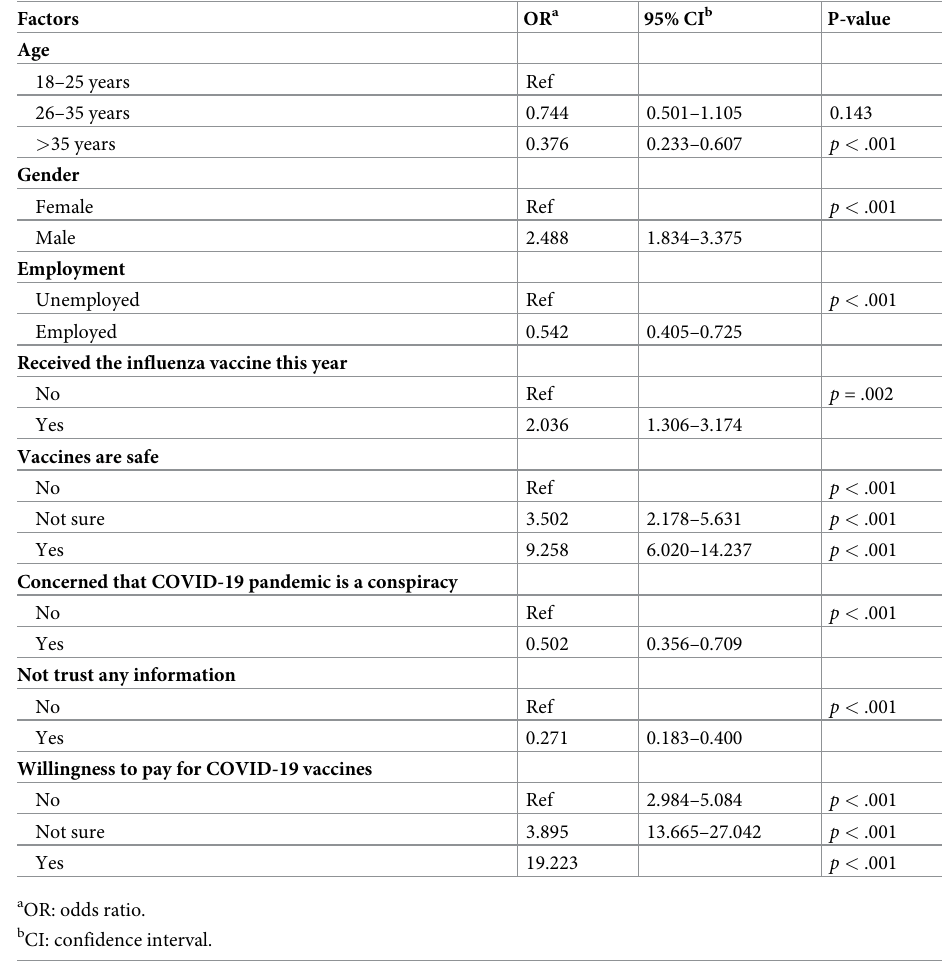
Table 2. Predictors of acceptance for COVID-19